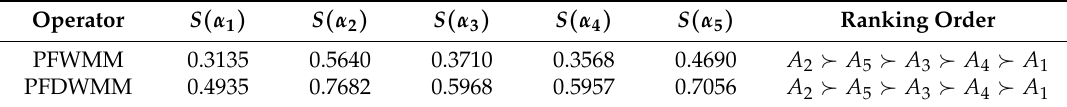
Table 7. The score values and the ranking results of five alternatives by two